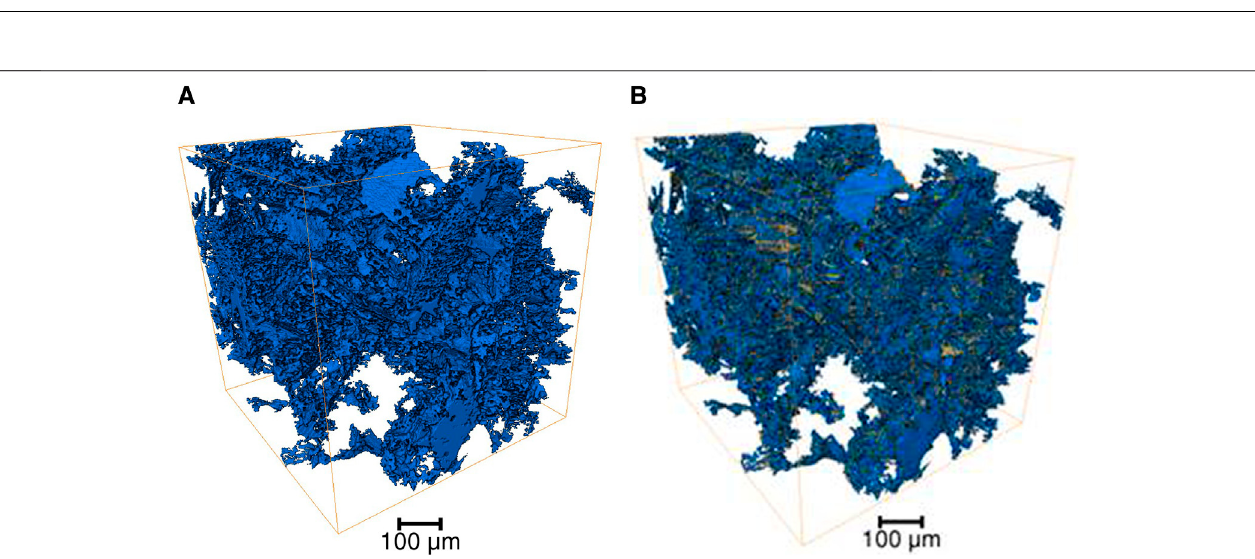
FIGURE 1 | Comparison of pore angles removed. (A) Original pore. (B) Pore without angles.